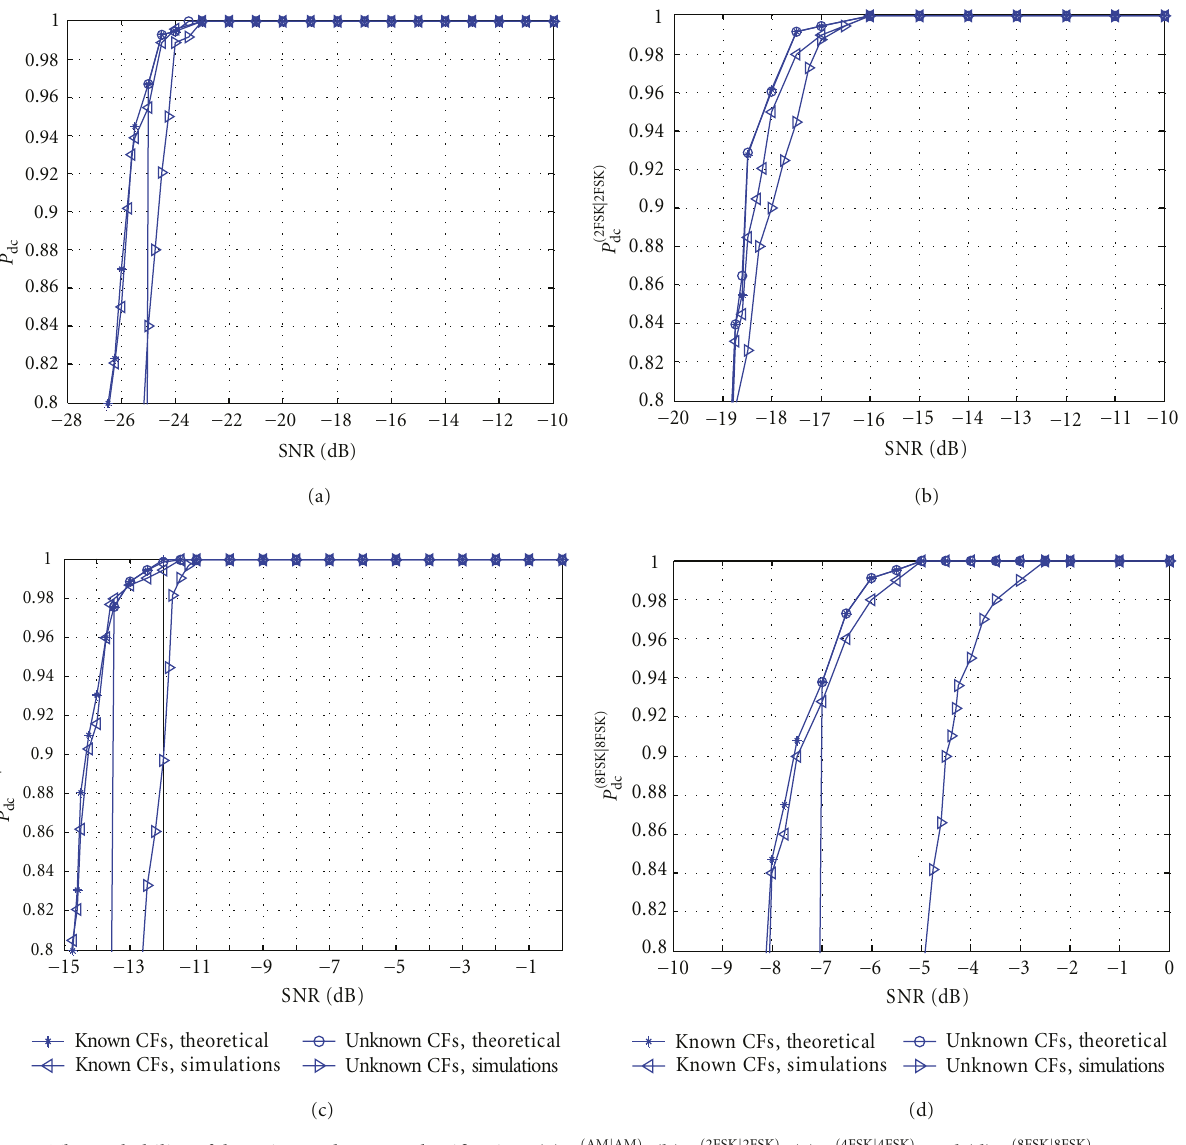
Figure 5: The probability of detection and correct classification, (a) P (AM | AM) with 1-second observation